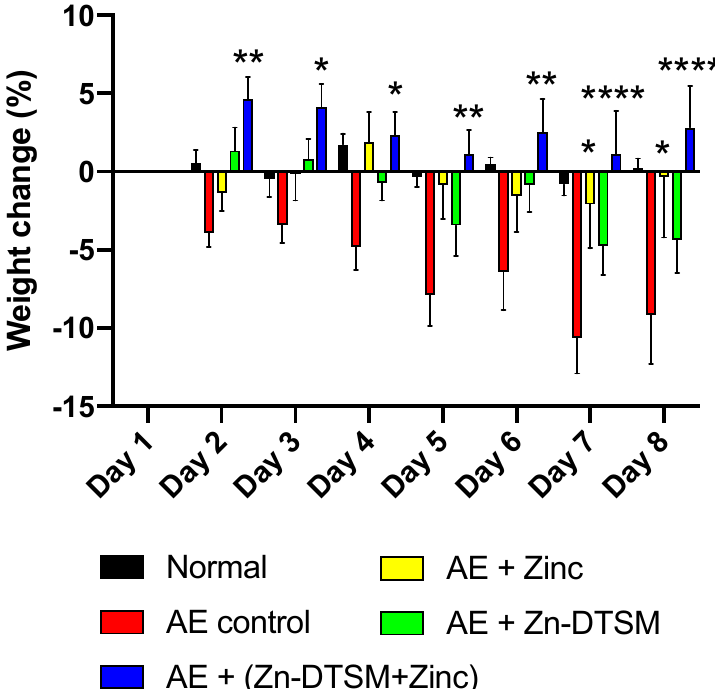
Figure 5. Weight change data (%) for older (5 month) acrodermatitis enteropathica (AE) animals treated with zinc diethyl bis(N4-methylthiosemicarbazone) (Zn-DTSM; 3 mg/kg/day). The AE control